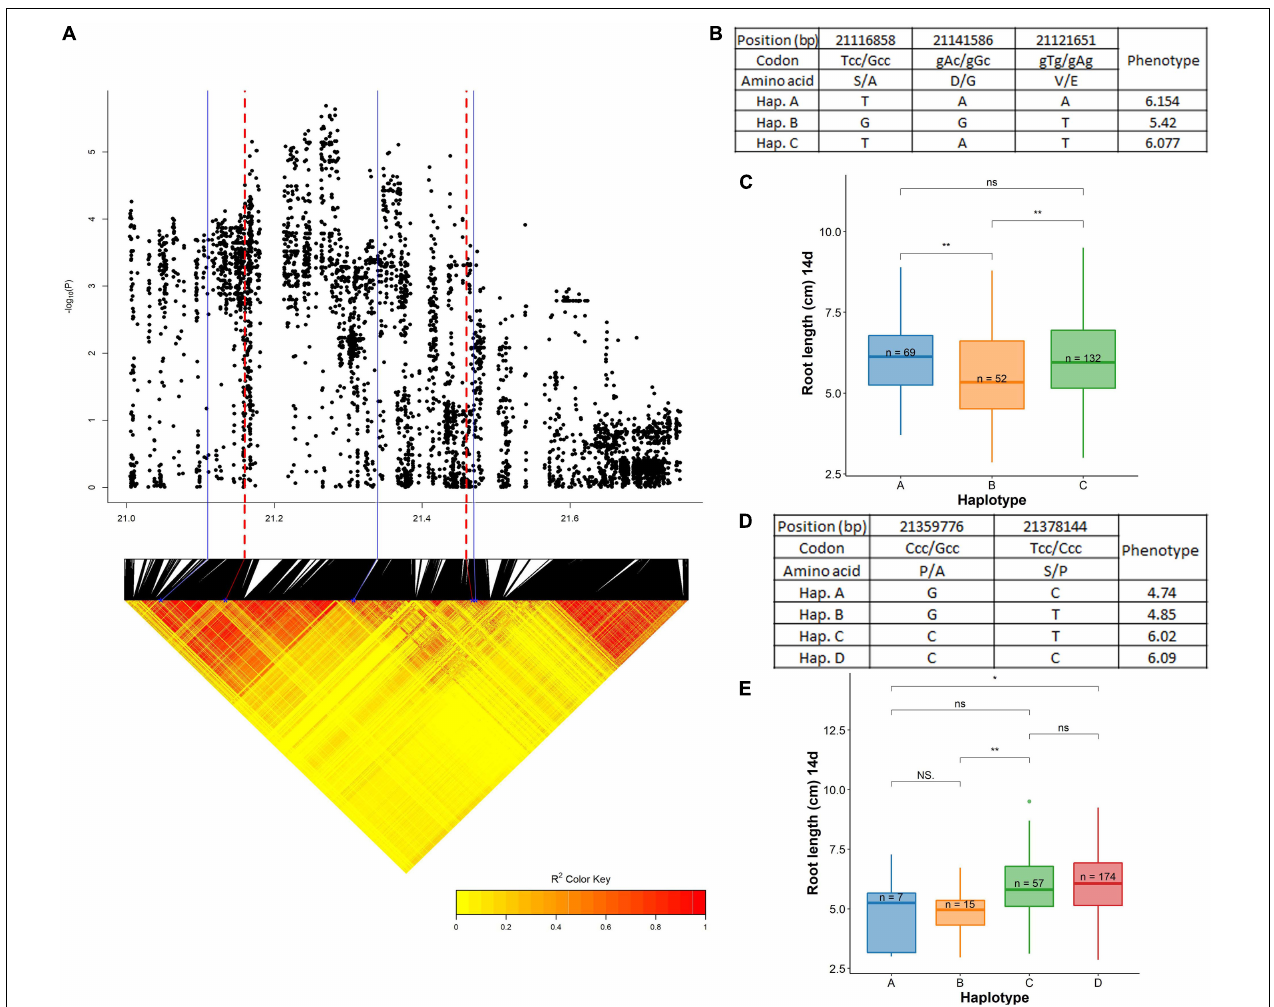
FIGURE 10 | Significant association for root length at 14 days on chromosome 7- 21.27 Mb. (A) Local Manhattan plot (top) and LD heat map (bottom) of QTL on chromosome 7, the blue solid line represents the candidate regions and red dash line represents the candidate genes OsRLCK234 (LOC_Os07g35280) and UCL22 ( LOC_Os07g35860); (B) the synonymous and non-synonymous SNPs in the candidate gene OsRLCK234 significantly associated with root length, and amino acid variations; (C) variation in root length at 14 days indicated haplotypes of OsRLCK234 ; (D) the synonymous and non-synonymous SNPs in the candidate gene UCL22 significantly associated with root length at 14 days, and amino acid variations; and (E) variation in root length at 14 days indicated haplotypes of UCL22. Significance level; * p < 0.05, ** p < 0.01, *** p < 0.001, **** p < 0.0001. ns, non